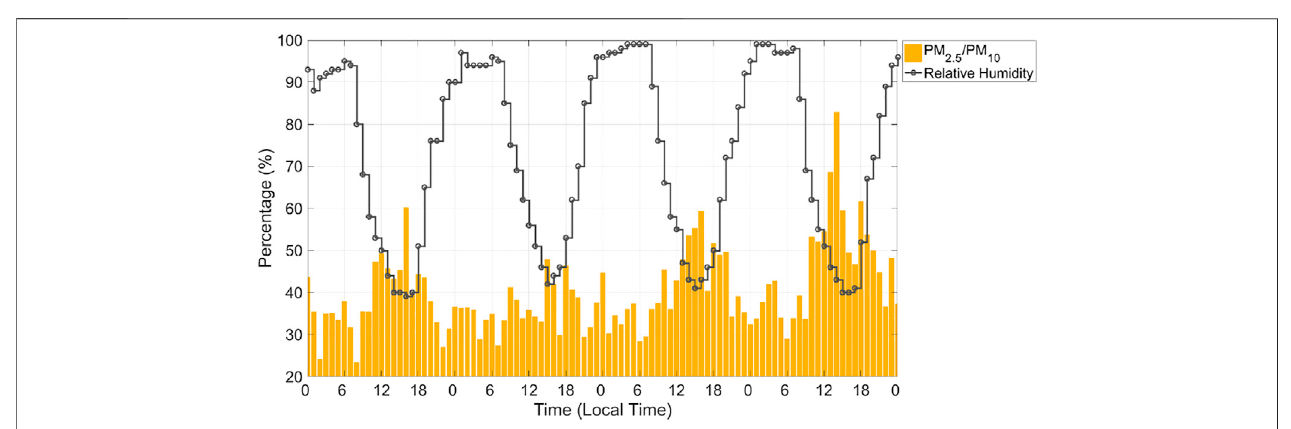
FIGURE 12 | Variation curves of ground relative humidity and PM 2.5 /PM 10